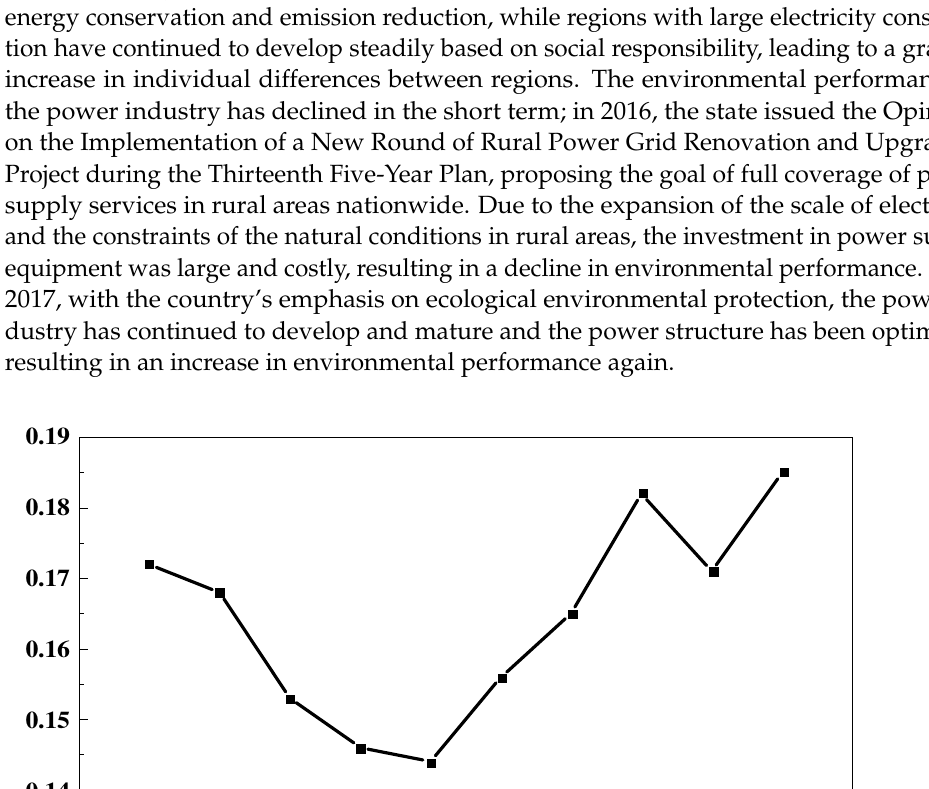
Figure 1. Trend of environmental performance of China’s power industry from the year 2010 to 2019.